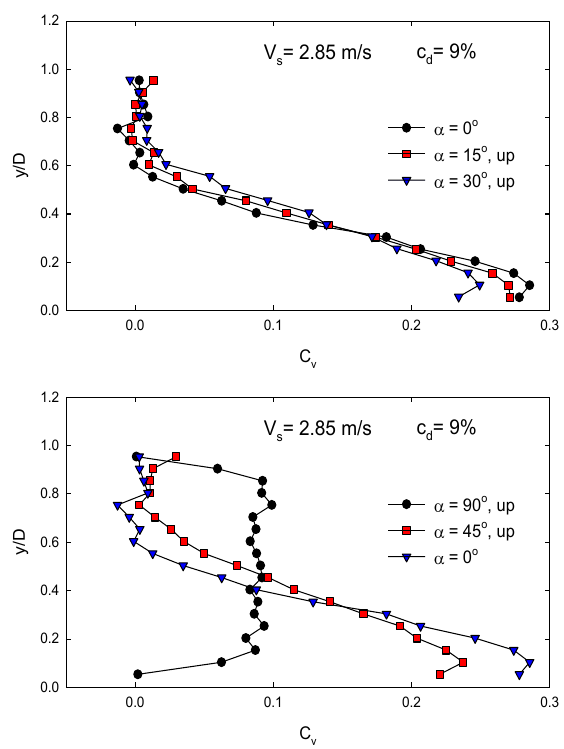
Fig. 5. Effect of the inclination angle on local concentration c v .